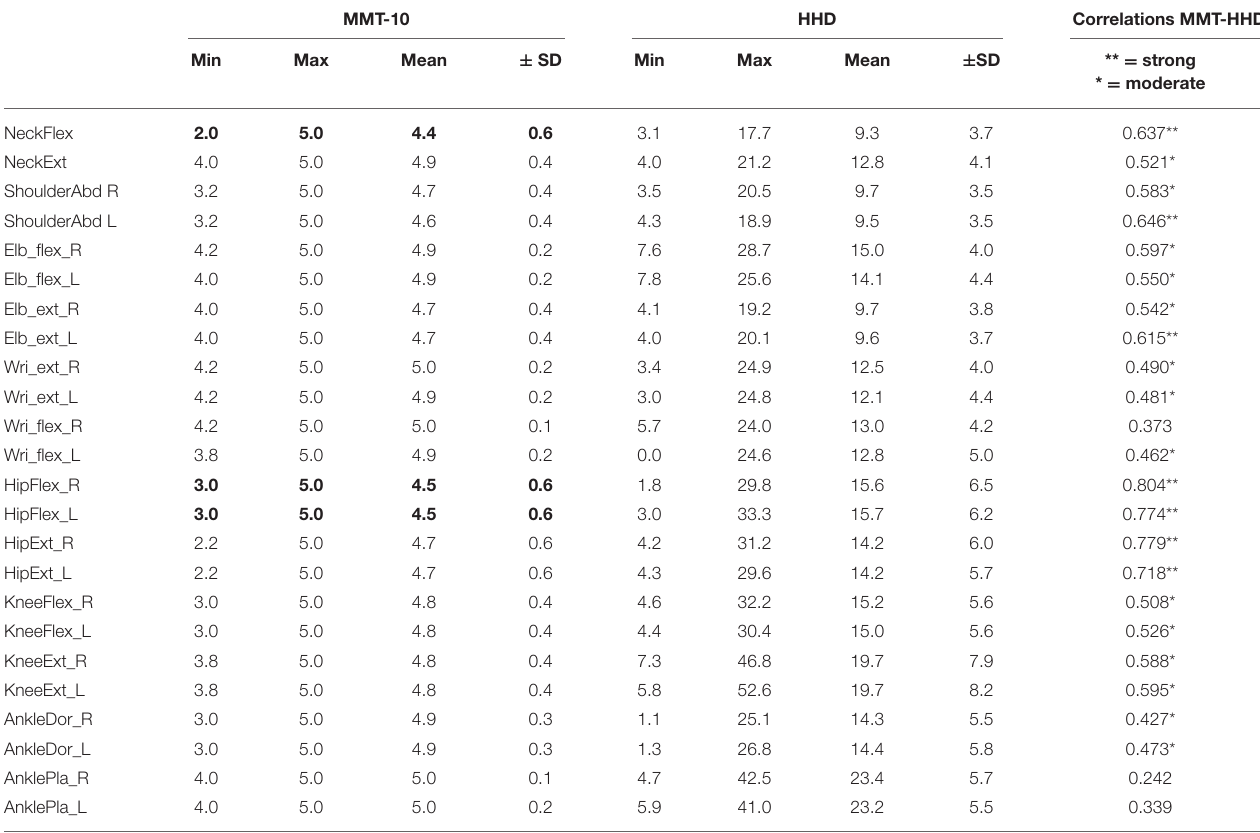
TABLE 3 | Muscle strength assessed by manual muscle testing (MMT) and hand-held dynamometry (HHD) at baseline (V0). MMT-10 HHD Correlations